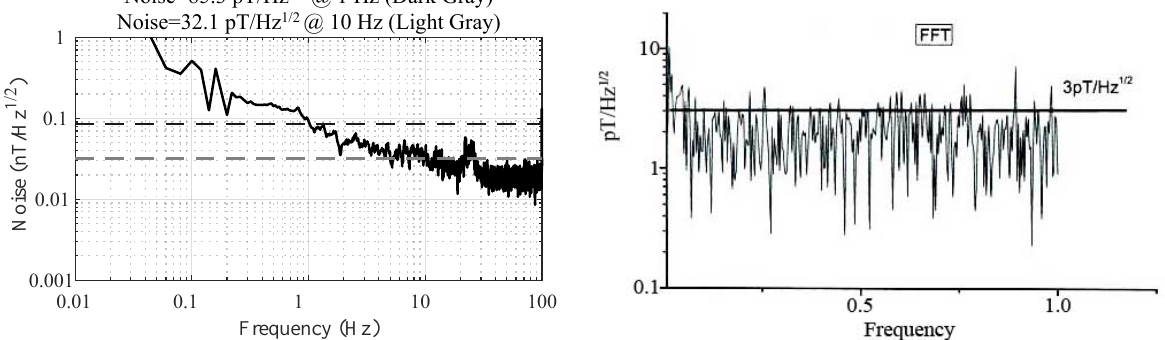
Figure 18. The noise power spectrum of the magnetometer as tested in the laboratory ( left ) and at the metering station ( right